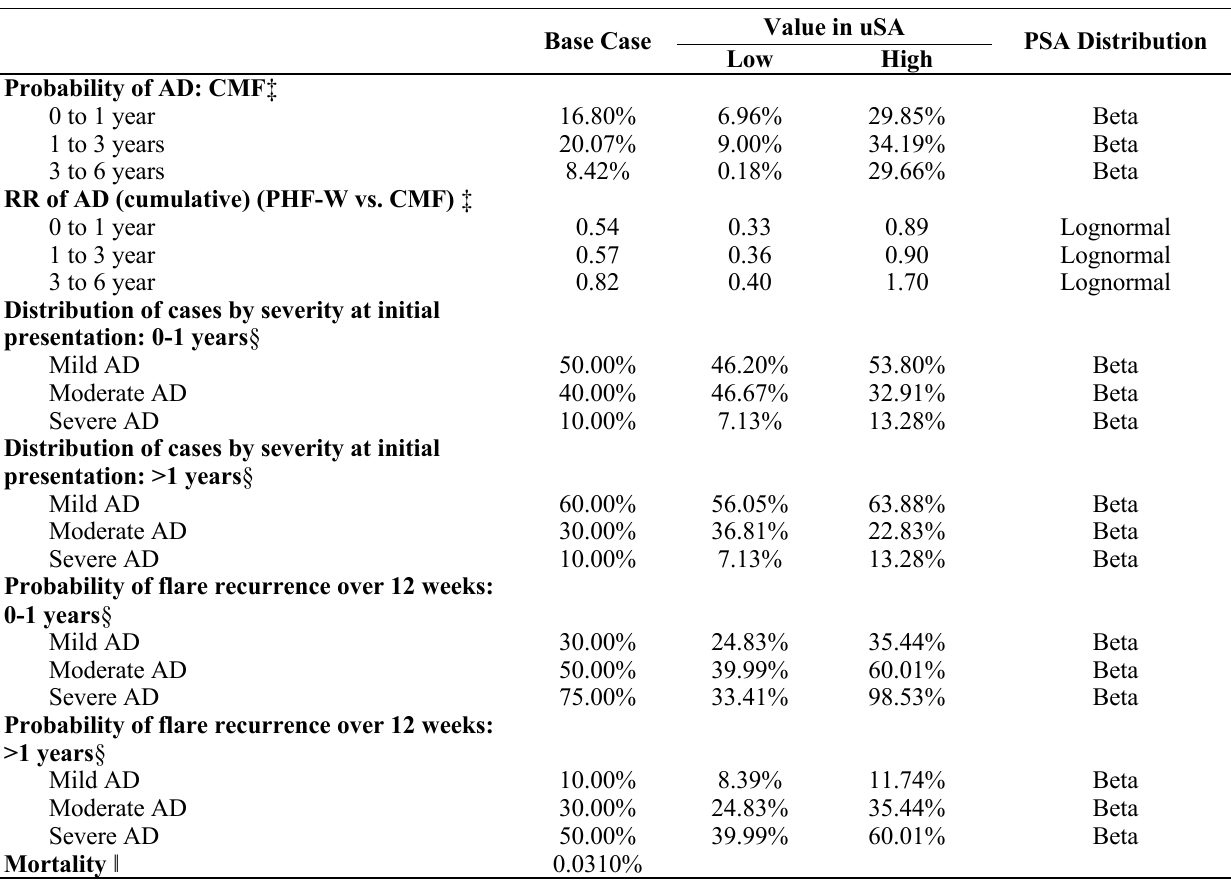
Table 1. Epidemiologic